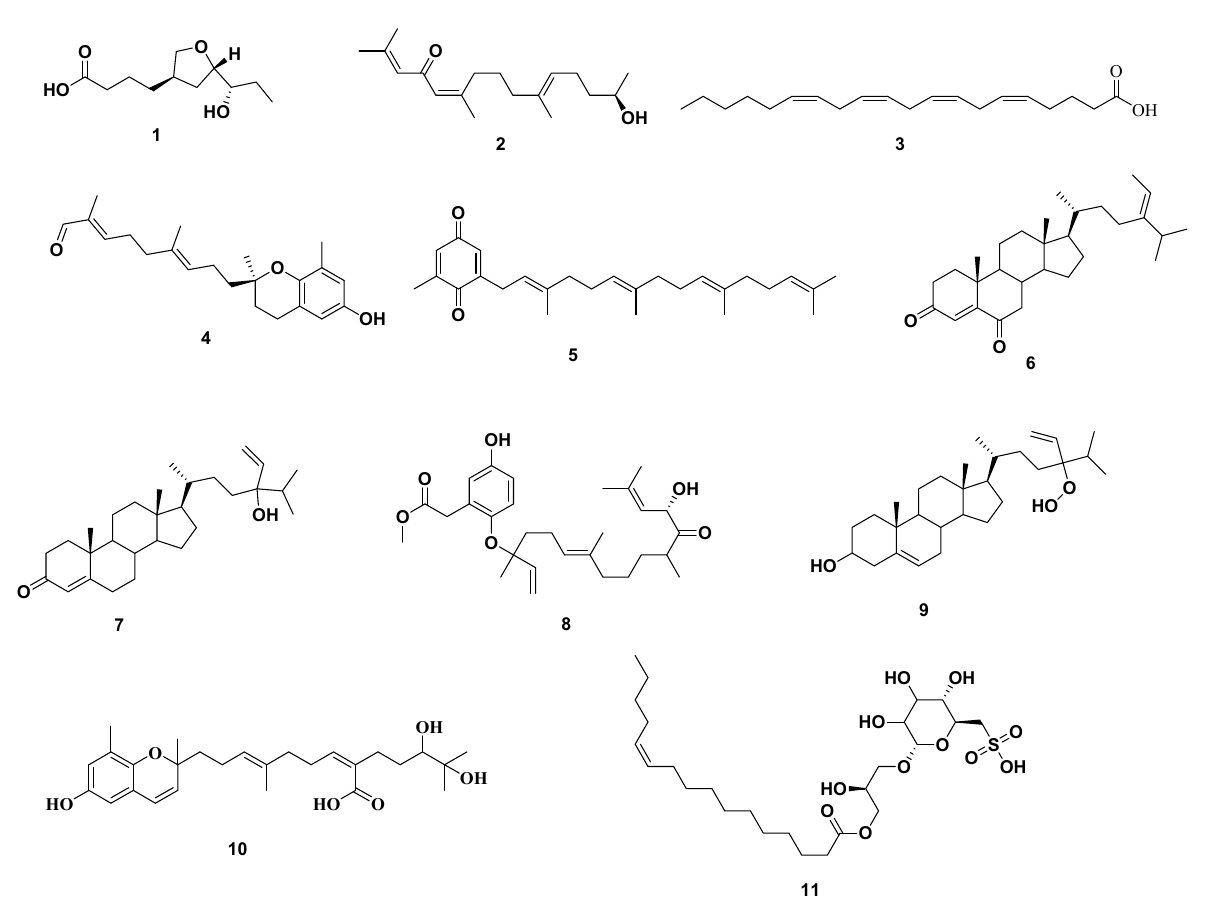
Figure 1. Dereplicated metabolites from liquid chromatography-high resolution electrospray ionization mass spectrometry (LC-HRESIMS) analysis of S. cinereum.